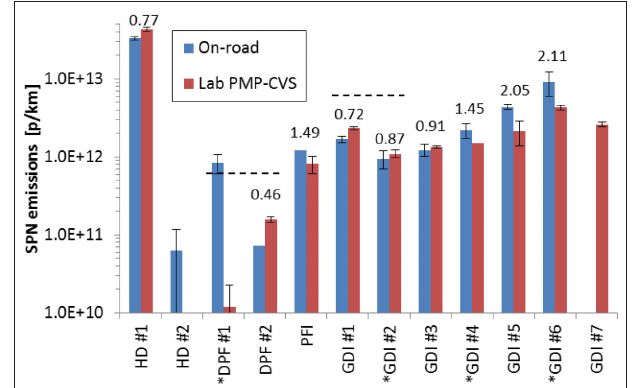
FIGURE 10 | SPN emissions of heavy-duty and light-duty vehicles on the road (PMP-TP) and in the laboratory (PMP-CVS). Asterisk indicates that PEMS-SPN was used instead of PMP-TP system for on-road measurements. DPF regeneration has been excluded from the emission measurements of Vehicles DPF #1 and DPF#2 when tested in the laboratory. On-road results are averages of all tested routes (see Table 3 ). Error bars indicate the range between minimum and maximum SPN emissions. Dashed lines depict the applicable emission limits. Numbers indicate the ratio of on-road to lab